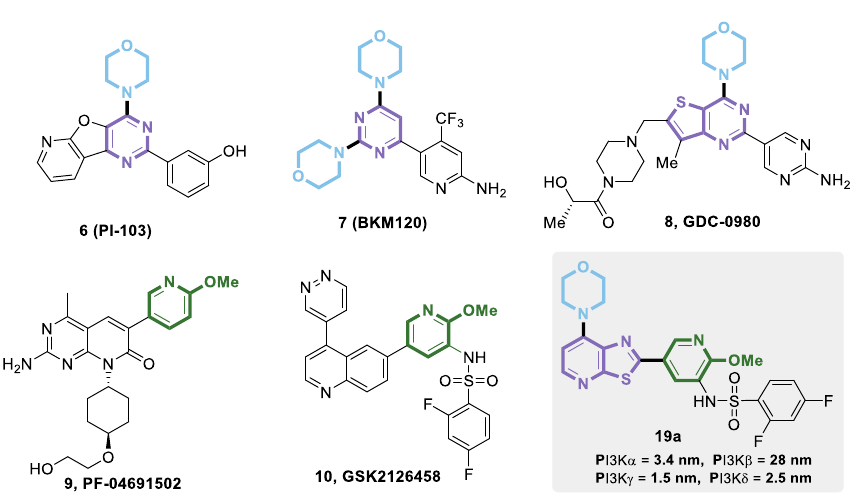
Figure 2. Design of 2-pyridyl, 4-morpholinyl substituted thiazolo[5,4- b ]pyridine PI3K inhibitor.